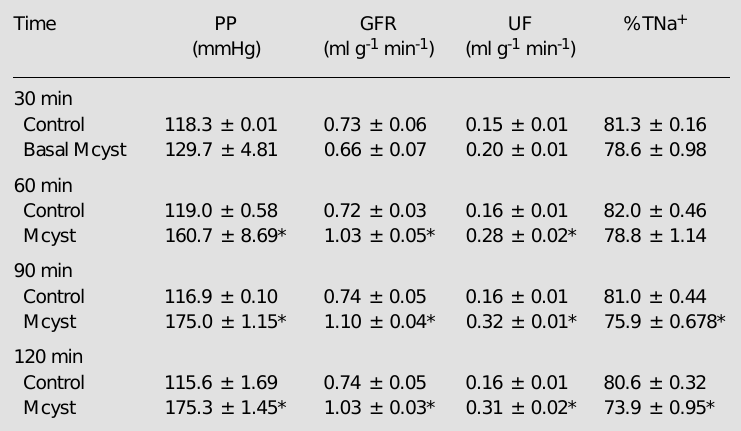
Table 1 - Effects of microcystin-LR on perfused rat kidney. The kidneys were perfused with 1 µM microcystin-LR (Mcyst) in modified Krebs- Henseleit solution and control conditions. Data are reported as mean ± SEM for 5 rats. *P<0.05 compared to control (Student t -test). PP, Perfusate pressure; GFR, glomeru- lar filtration rate; UF, urinary flow; %TNa + , fractional sodium tubular